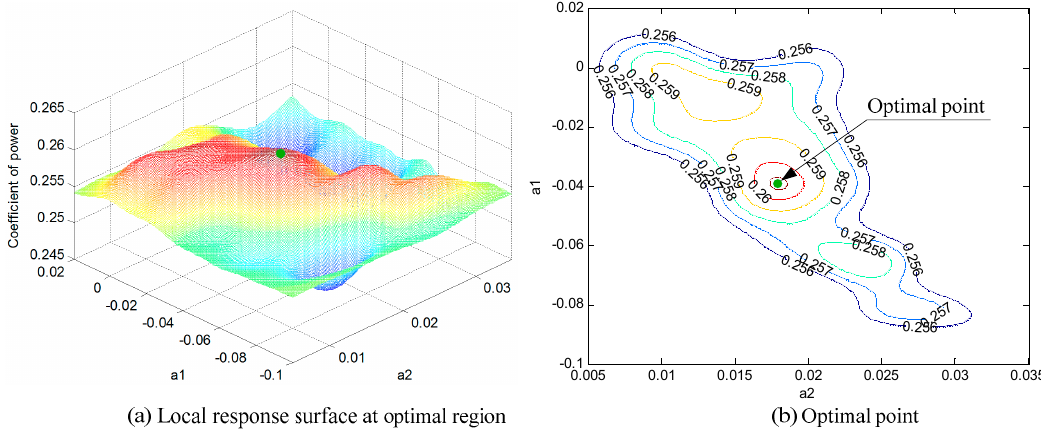
Figure 13. Local response surface and optimal point.